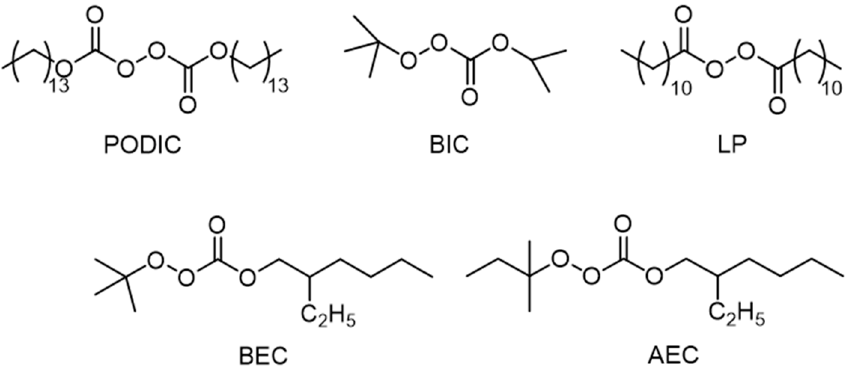
Figure 2. Schematic structure of the peroxides.